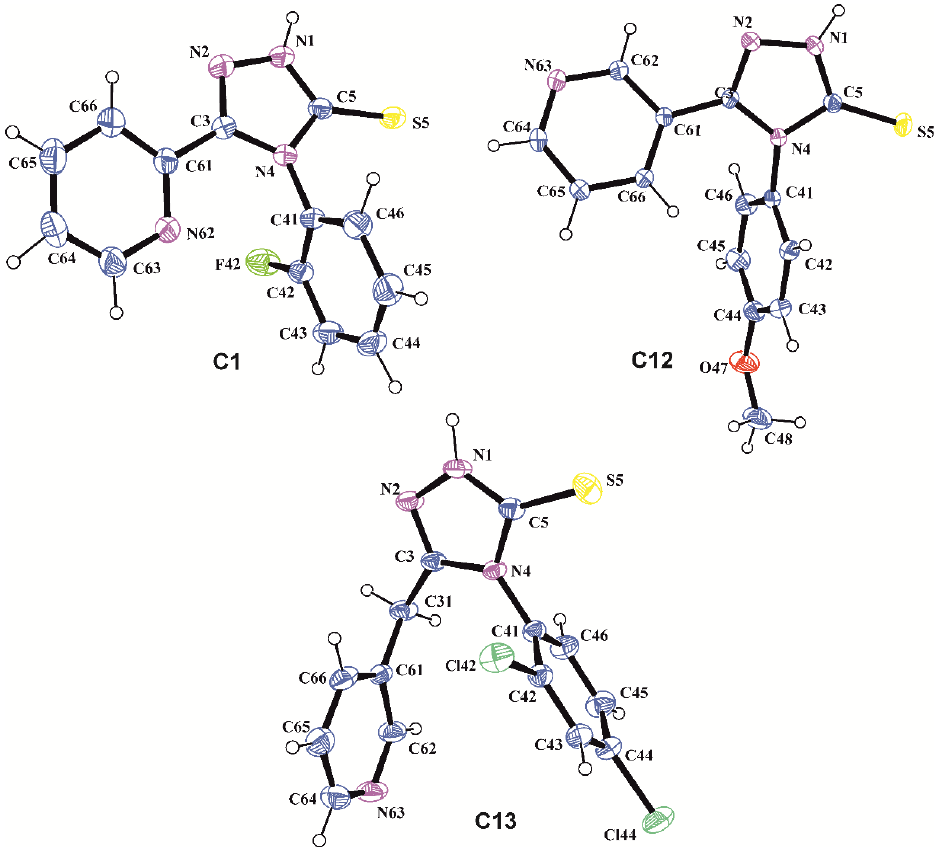
Figure 1. The molecular structures of C1, C12, and C13 with atom labeling and displacement ellipsoids drawing at the 30% probability level.